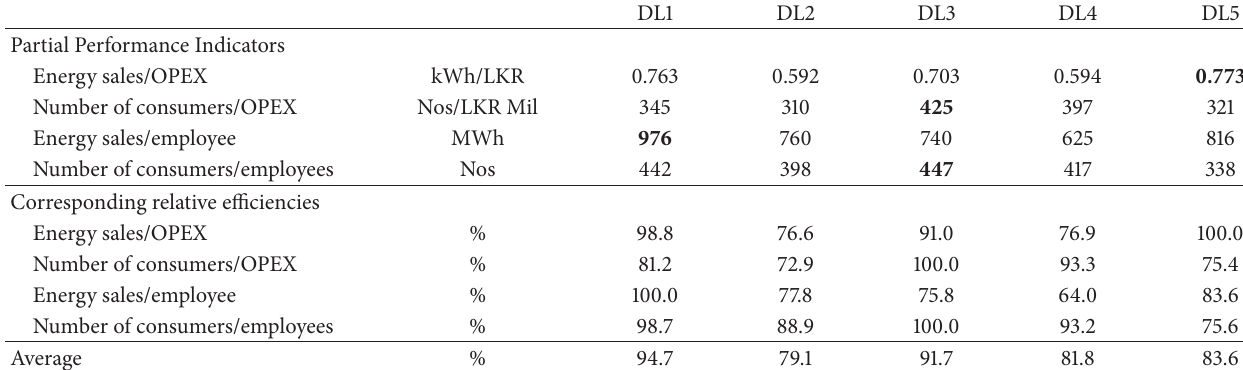
Table 9: Efficiency scores from